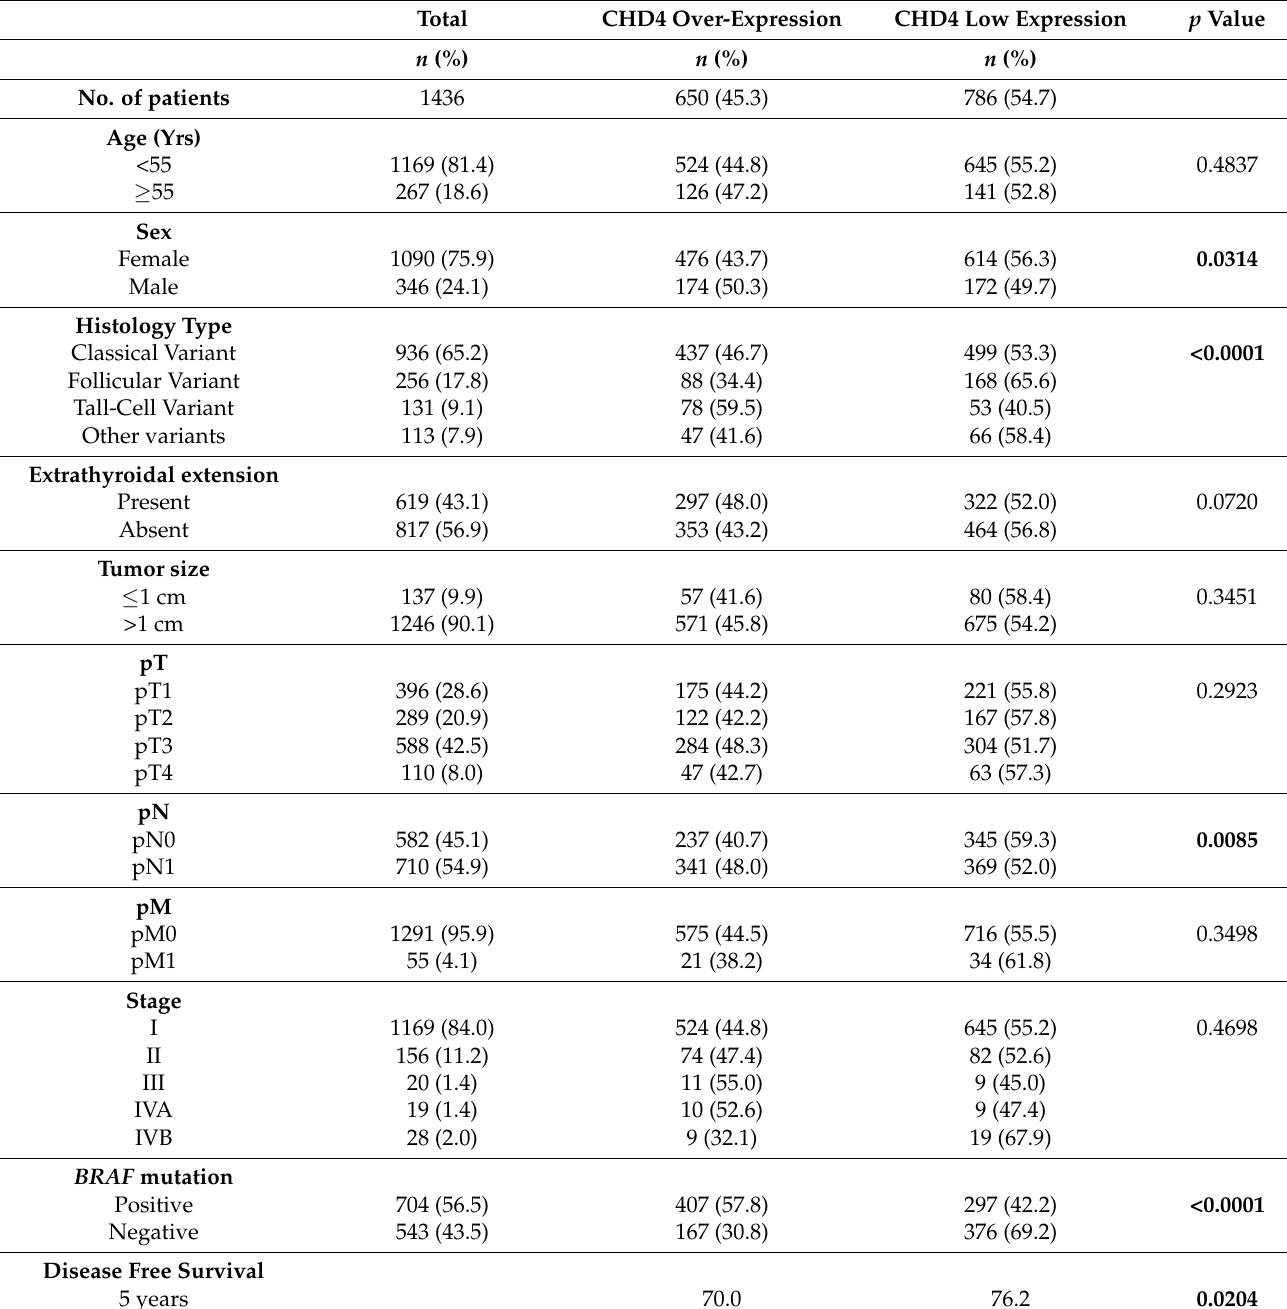
Table 2. Clinico-pathological associations of CHD4 protein expression in Papillary Thyroid